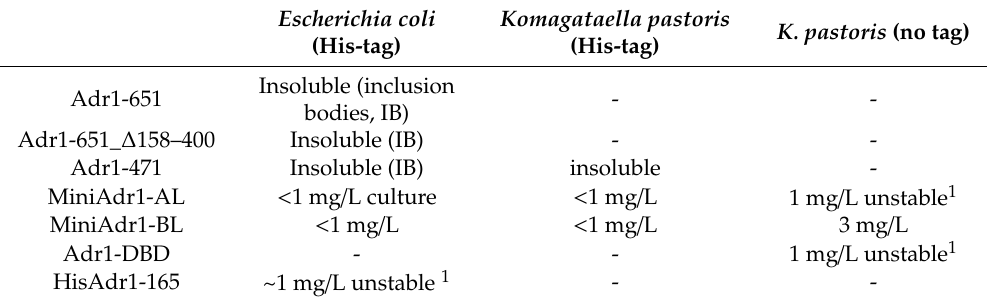
Table 1. Final yields of miniAdr1 proteins produced in this study as functions of purified soluble proteins (see Figure 1B for their primary